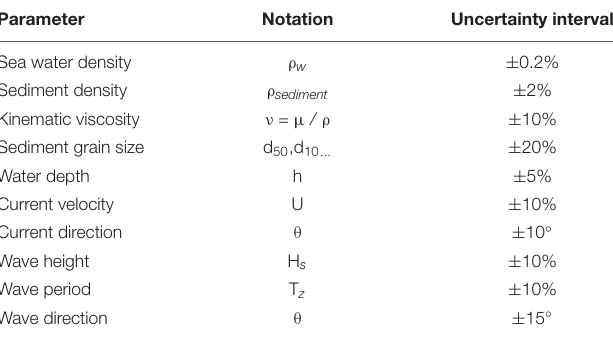
TABLE 2 | Some common variation intervals for the main parameters that affect sand transport calculations, modified after (Soulsby, 1997).